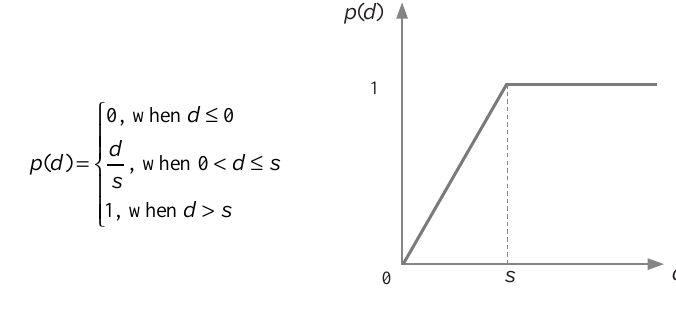
Fig. 3. V-shape preference function and its